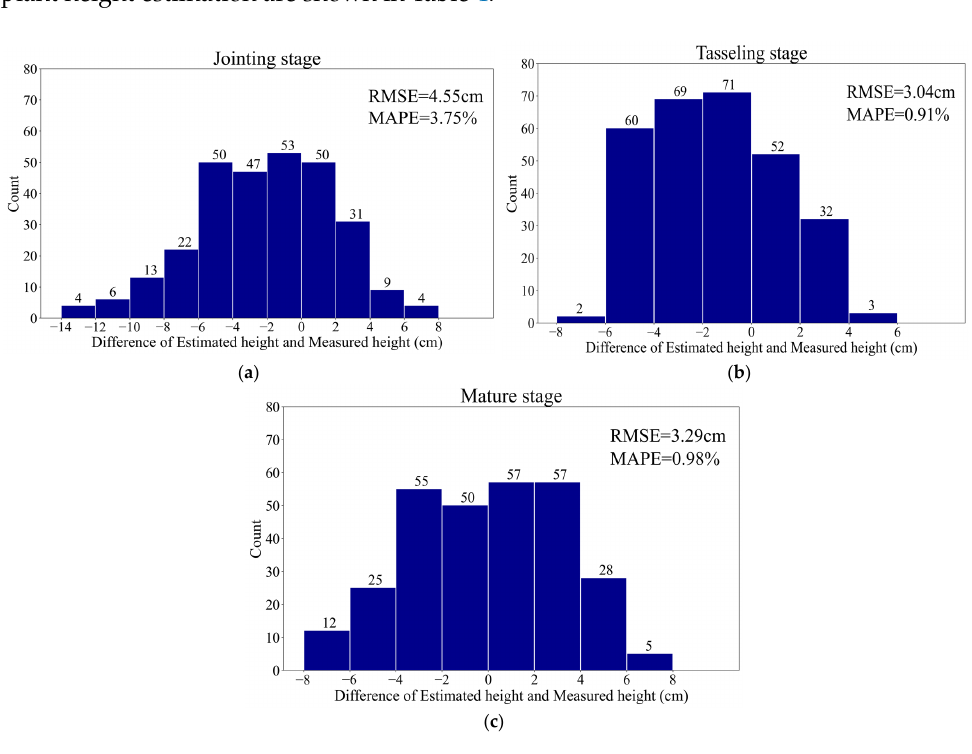
Figure 13. The maximum elevation of LiDAR data, the elevation of DTM, and the estimated height: ( a ) A1, ( b ) A2.